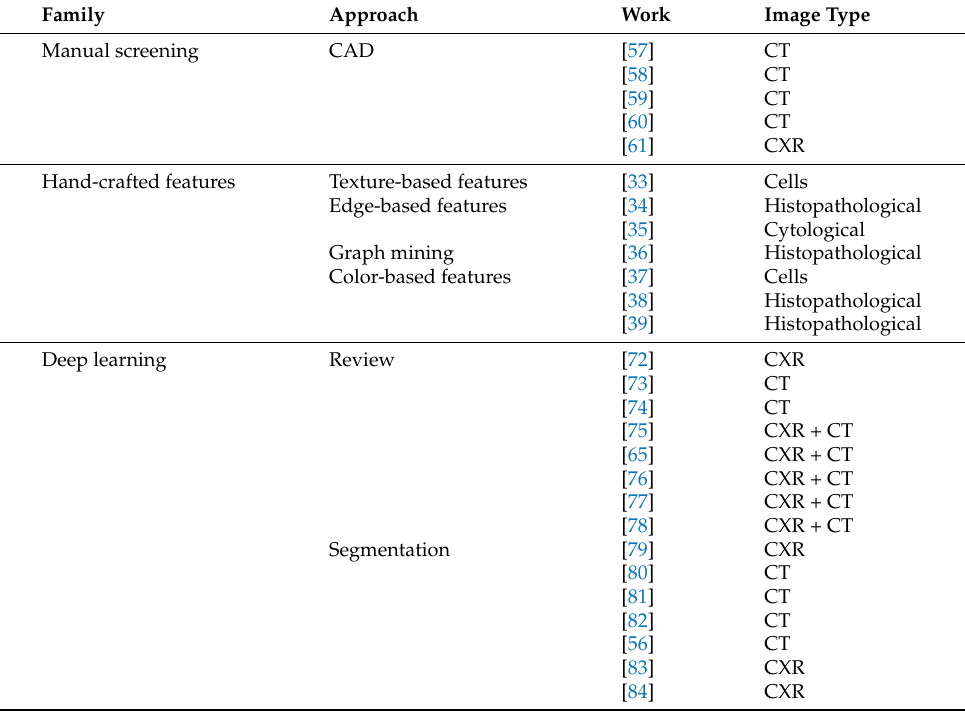
Table 1. A synoptic view of the main related